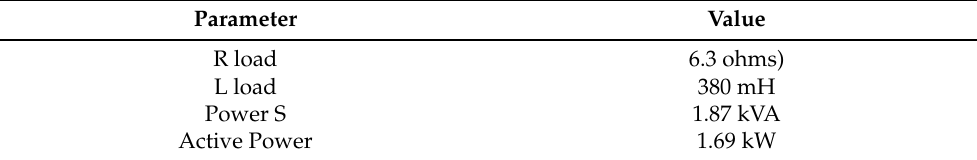
Table 4. Retifier load parameters.